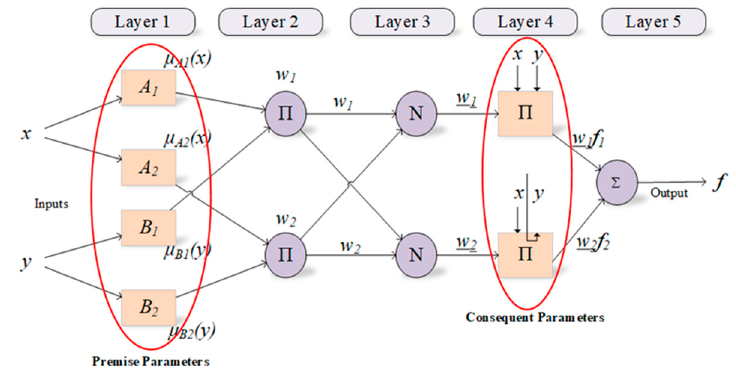
Figure 1. Structure of ANFIS and parameters used in training process.